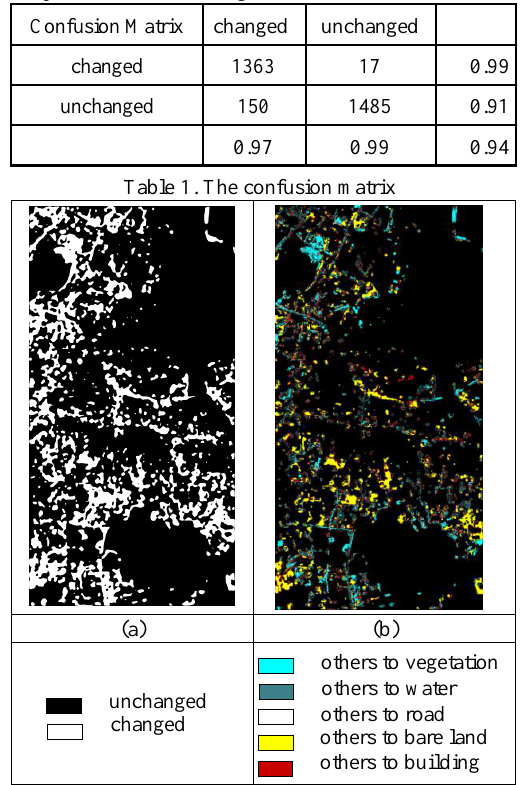
Figure 18. The extraction results of the five typical objects (a)2012; (b)2013 Figure 19 (a) shows binary change detection results. The accuracy evaluation of the change detection was done by visually selecting samples of the changed and unchanged areas. The confusion matrix is shown in Table 1. The overall accuracy is 0.94 and the kappa coefficient is 0.89. In addition, changes in each object were detected (Figure 19 (b) ).